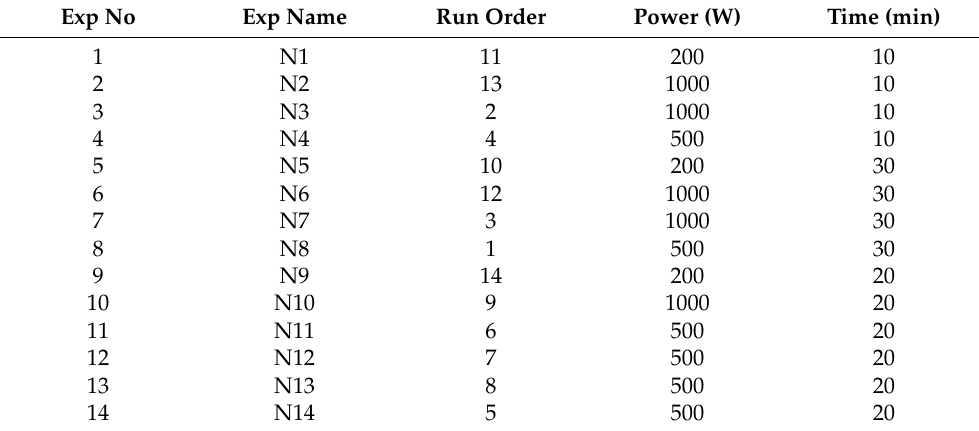
Table 1. Experimental parameters set by DoE for the optimization of the extraction method. Exp